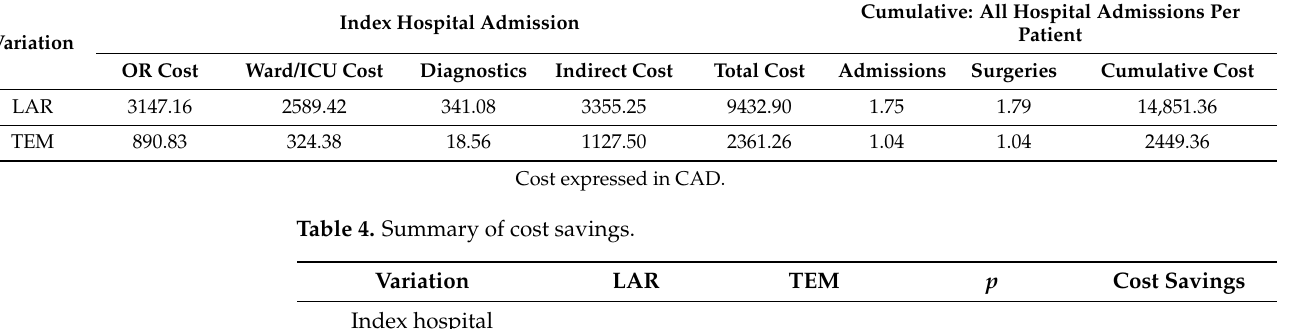
Table 3. Mean cost comparison LAR vs. TEM.